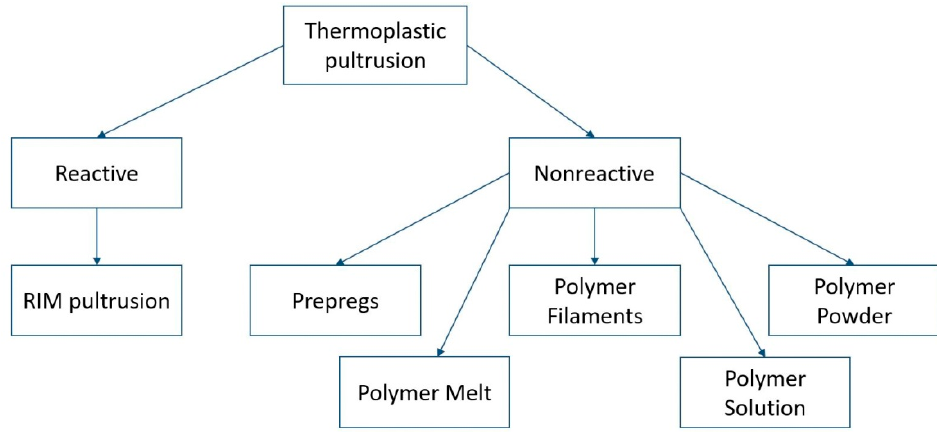
Figure 1. Thermoplastic pultrusion types.